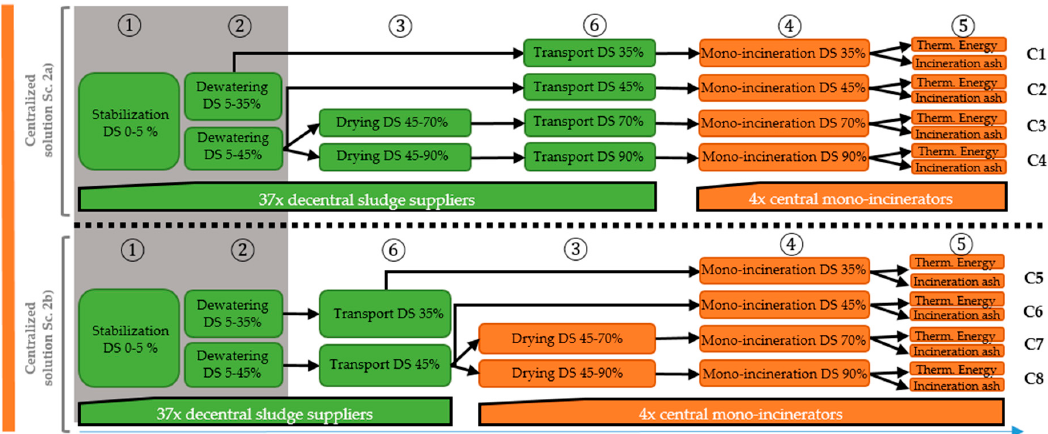
Figure 8. Centralized scenarios 2( a ), ( b ) including sludge pre-treatment options 1–4.